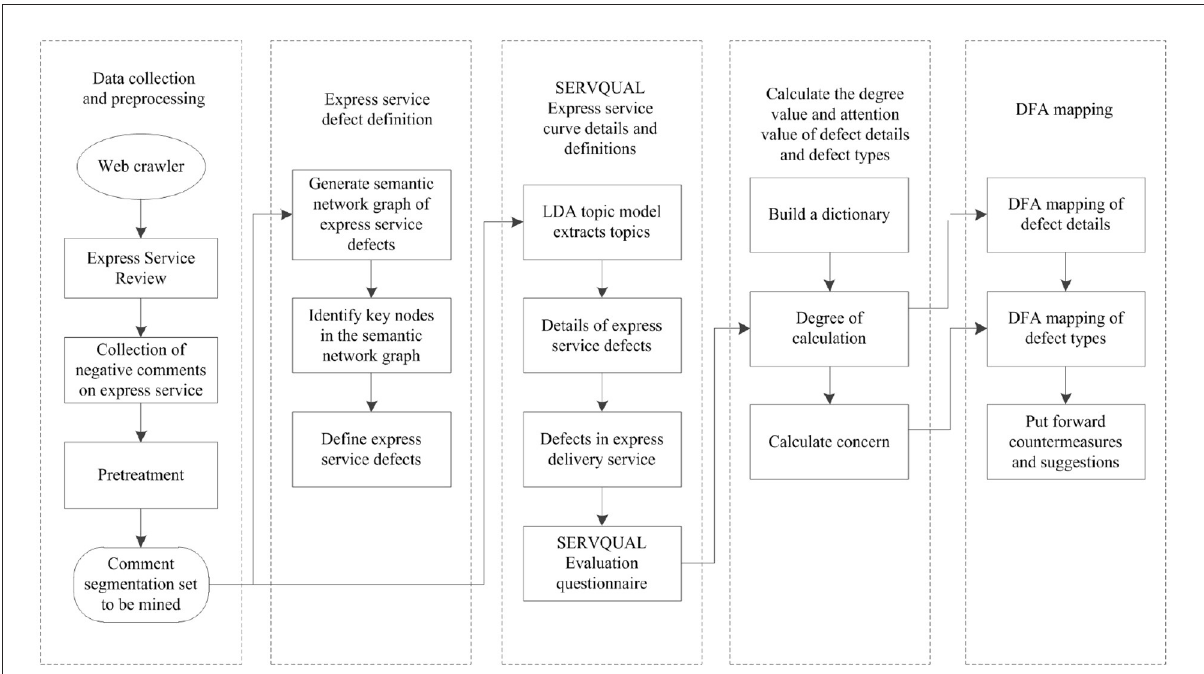
FIGURE1 Evaluation framework of express service defect based on semantic network diagram-SERVQUAL